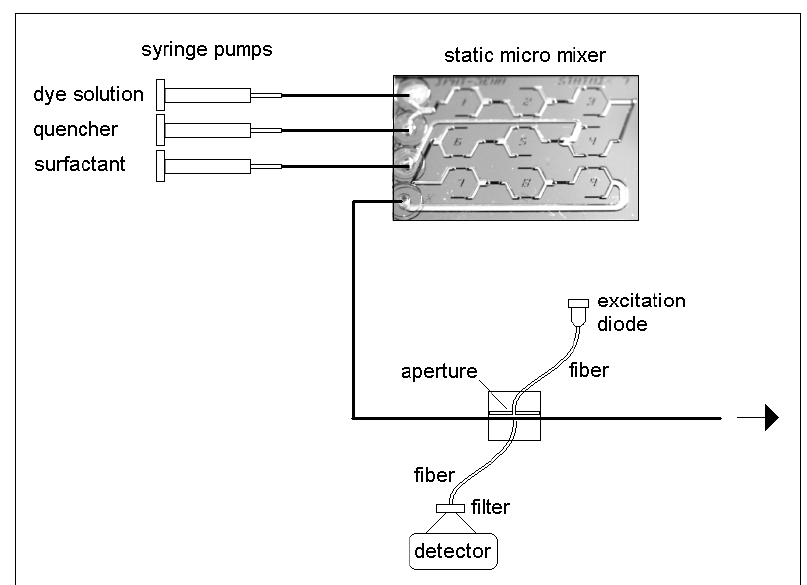
Figure 1. Experimental arrangement for formation and characterization of micelles in a microfluidic